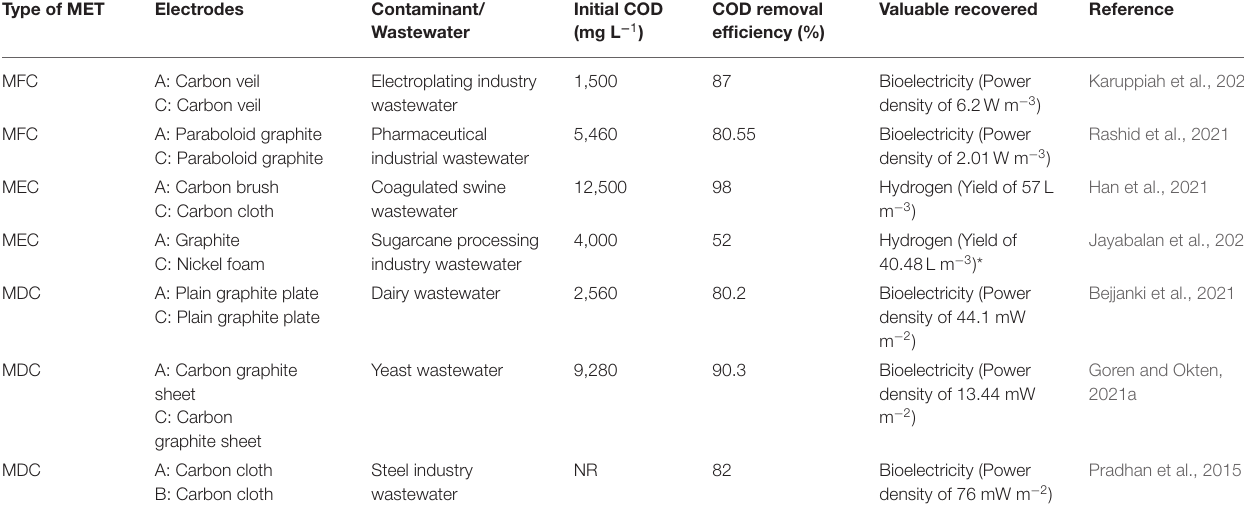
TABLE 4 | Treatment of different types of wastewaters using METs. Type of